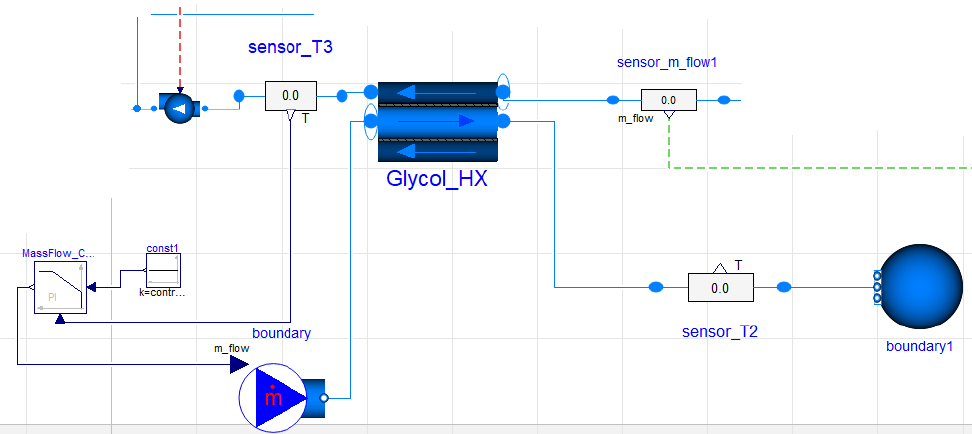
Figure 7. Ethylene glycol heat exchanger.